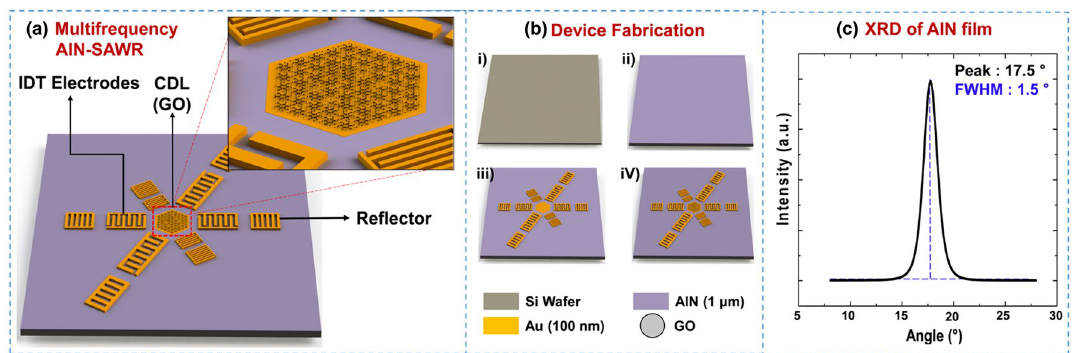
Figure 1. ( a ) The configuration of SAWR consisting of IDTs, reflectors, and CDL. ( b ) A fabrication process of SAWR with a GO layer. ( c ) XRD analysis of AlN